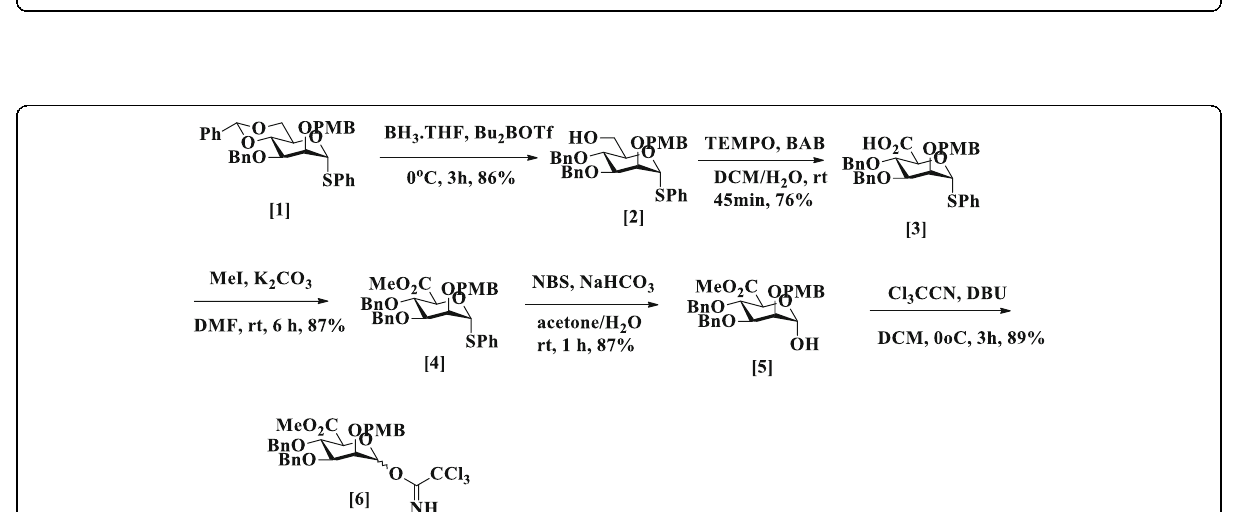
Scheme 53 Synthesis of R6G-labelled oligonucleotides by CuAAC